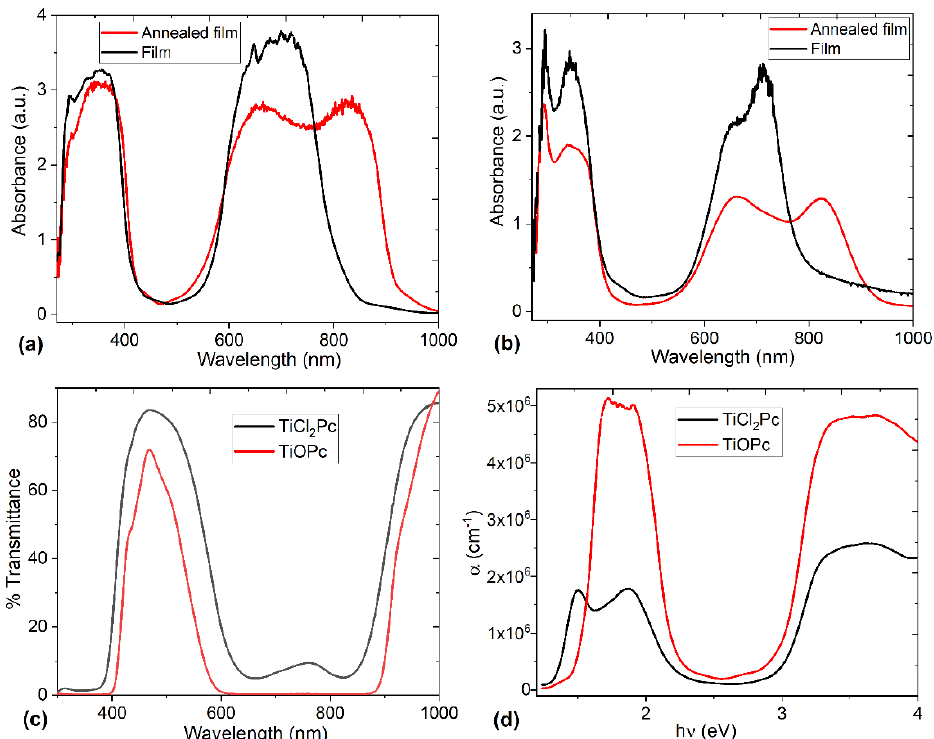
Figure 6. Absorbance spectra of ( a ) TiOPc and ( b ) TiCl 2 Pc films before and after annealing. ( c ) Transmittance and ( d ) absorption coefficient of TiOPc and TiCl 2 Pc films after anneal- ing.